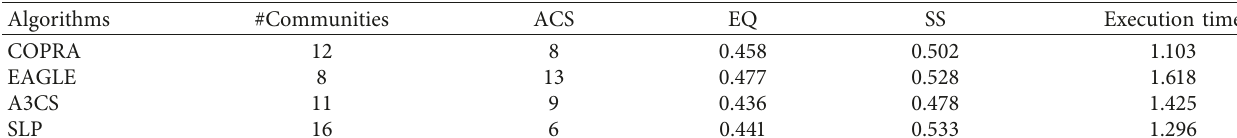
Table 2: The comparison of the four community detection algorithms on MIT Reality.